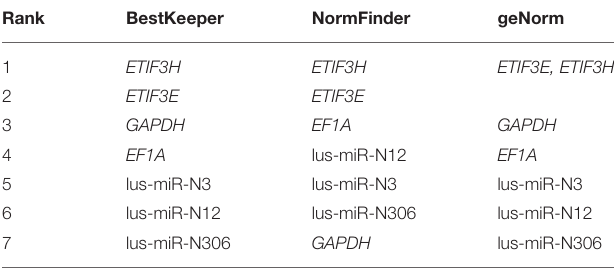
TABLE 2 | The results of BestKeeper, NormFinder, and geNorm analysis.